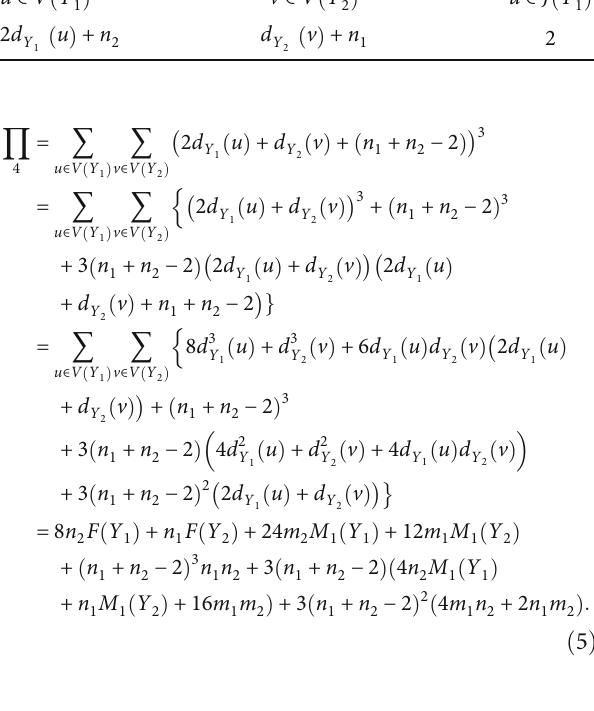
Table 3: The degree distribution of Y